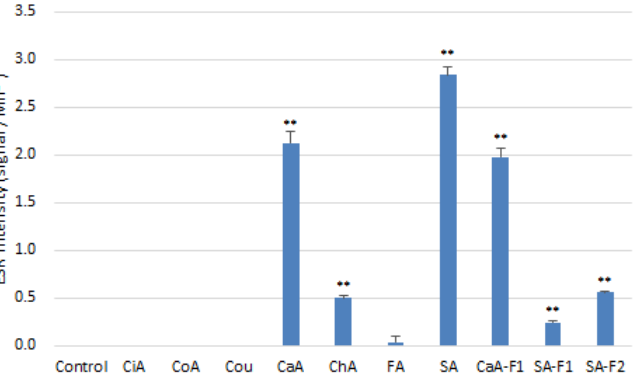
Figure 7. Prooxidant activities produced by the reaction between HCAs and copper ions. Results are presented as the mean ± SD for three independent experiments. ** indicate significantly different values at p < 0.05 and p < 0.01, respectively. Table 1. Trolox equivalent antioxidant capacities (mmol Trolox equivalent/mmol) for various HCAs and related compounds. Results are presented as the mean ± SD for three independent experiments.